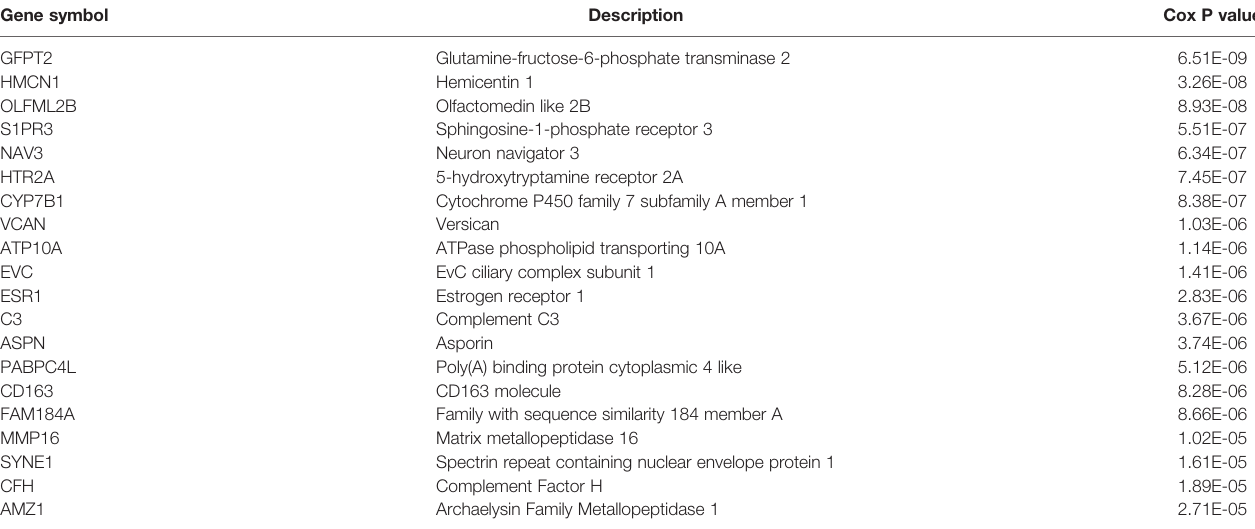
TABLE 2 | Top 20 genes that in fl uence prognosis signi fi cantly.